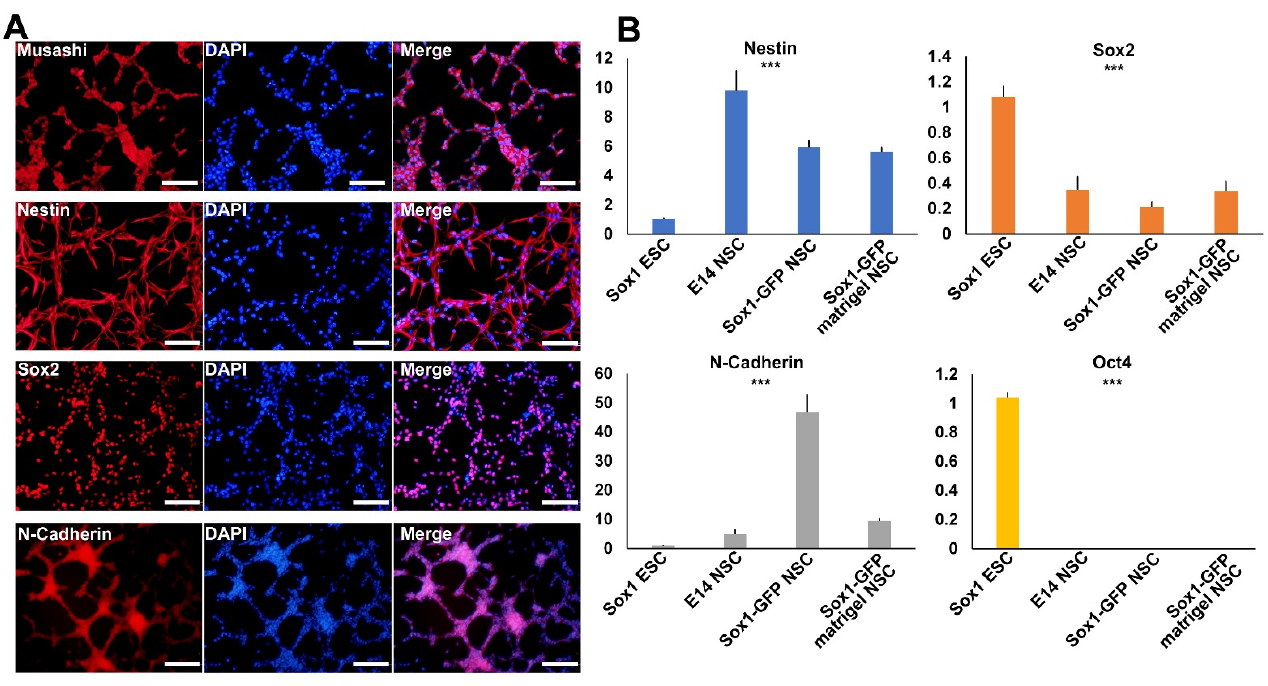
Figure 3. Characterization of the established NSCs. ( A ) Immunofluorescence analysis of established NSCs using NSC- specific markers, namely Musashi, Nestin, Sox2, and N-cadherin. Scale bars = 200 μ m. ( B ) Real-time RT-PCR analysis of established NSCs using NSC marker genes, namely Nestin, Sox2, N-cadherin, and pluripotent marker gene Oct4. One-way ANOVA: *** p < 0.001 ( n = 3).